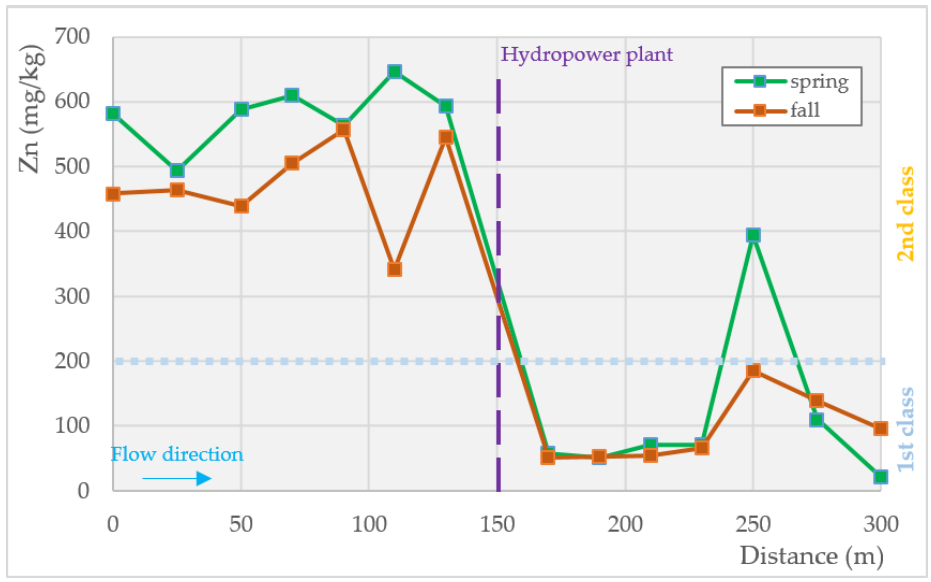
Figure 8. Changes in zinc concentrations in sediments in spring and fall near the hydropower plant on the Ślęza River, along with the geochemical classification.